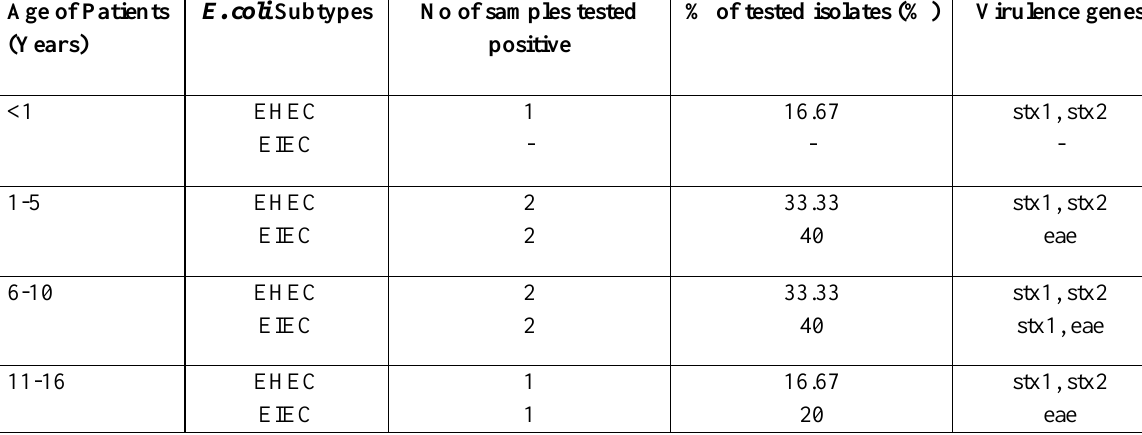
Table 5. Distribution of virulence factors in E.coli